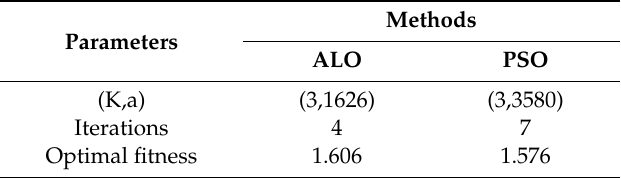
Table 3. Comparison of optimization performance between ant lion optimization (ALO) and particle swarm optimization (PSO).